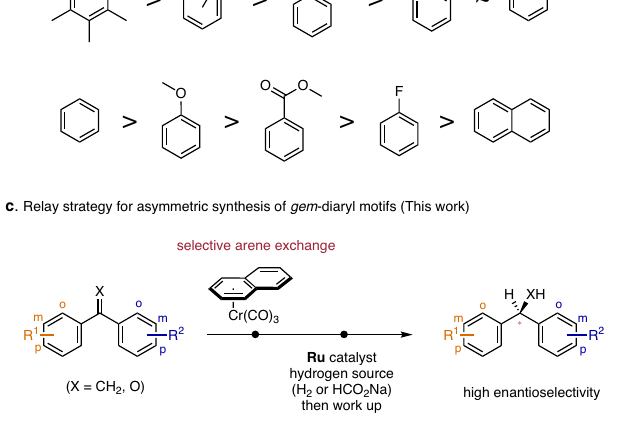
Fig.2|Asymmetricreductionofchromium η 6 -arenecomplexes.a Synthesisand Corey-Bakshi-Shibata (CBS) reduction of Cr(CO) 3 benzophenone complex. b RelativestabilityofCr(CO) 3 arenecomplex. c Thiswork:synthesisofcompounds bearing achiral gem -diarylmotiffrom either 1,1-diarylethylenes orbenzophenones by a sequence involving selective arene exchange and stereoselective asymmetric